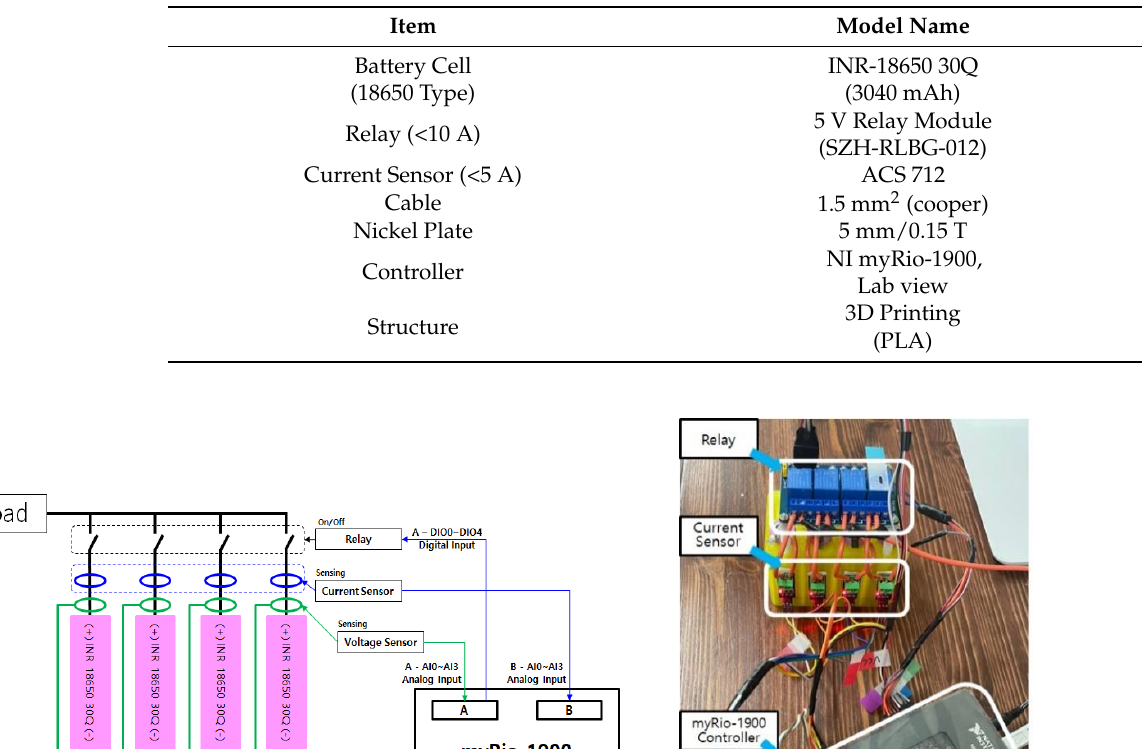
Table 1. Components of 1S4P lithium battery pack.